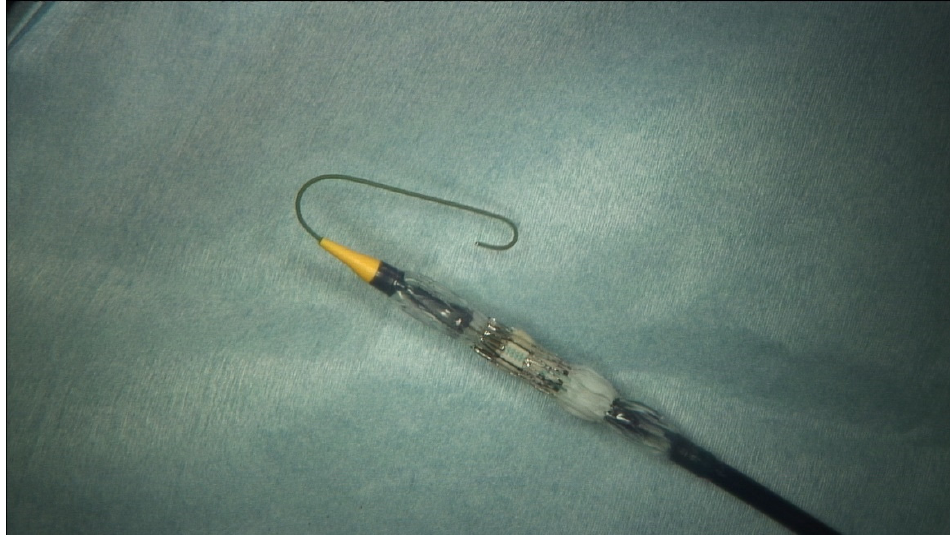
Figure 3. Modified delivery system.